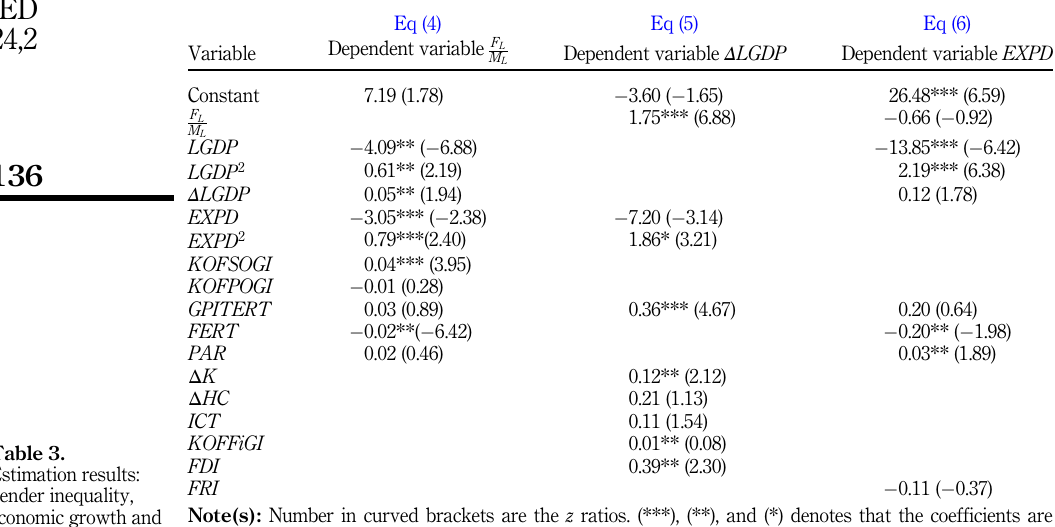
Table 3. Estimation results: gender inequality, economic growth and globalization,